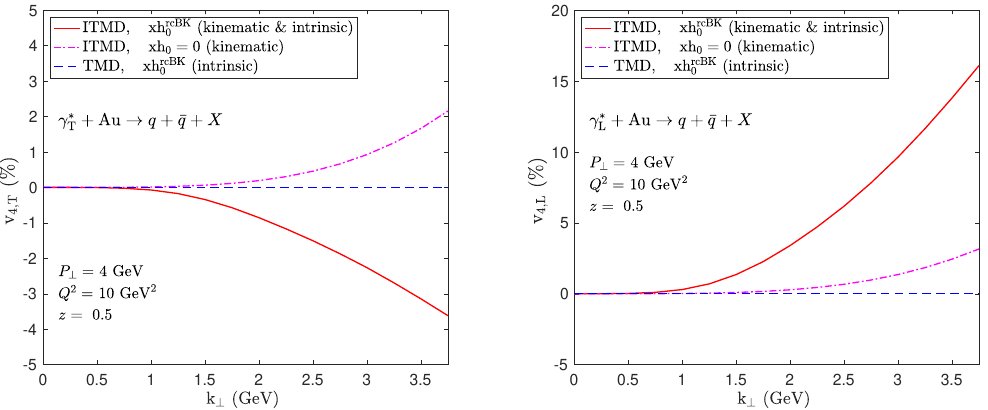
Figure 11 . Quadrangular anisotropy in γ ∗ + Au → q + ¯ q + X : for transversely polarized photons λ (left), and longitudinally polarized photons (right). We show results in the TMD and ITMD framework. To illustrate the effect purely from kinematic twists, we also show the result for the ITMD in which we turn off the linearly polarized WW gluon TMD (dashed dotted).